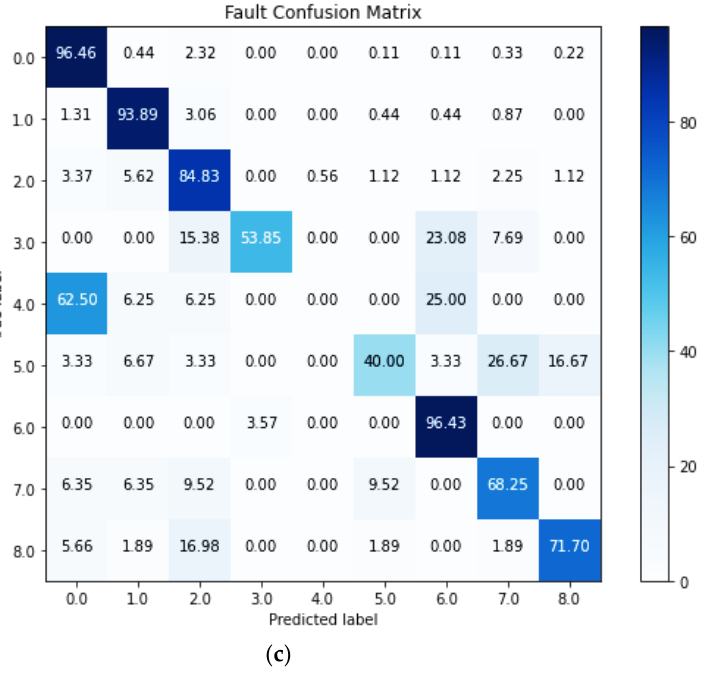
Figure 8. Confusion matrices of the three best-performing classifiers trained on all fault data: ( a ) Random Forest; ( b ) Nearest Neighbors; and ( c ) Neural Net. Table 7. Comparison of the accuracy metrics for supervised algorithms trained and evaluated on a dataset without F4 and F5.